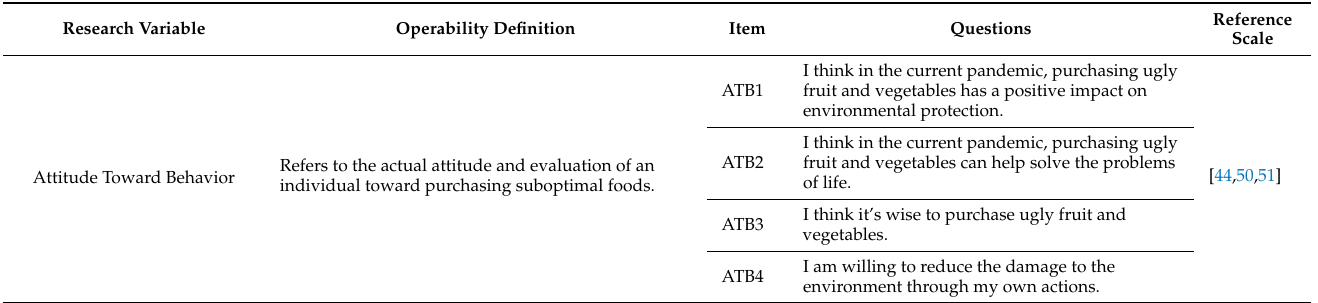
Table 1. Definition of variable operability and reference